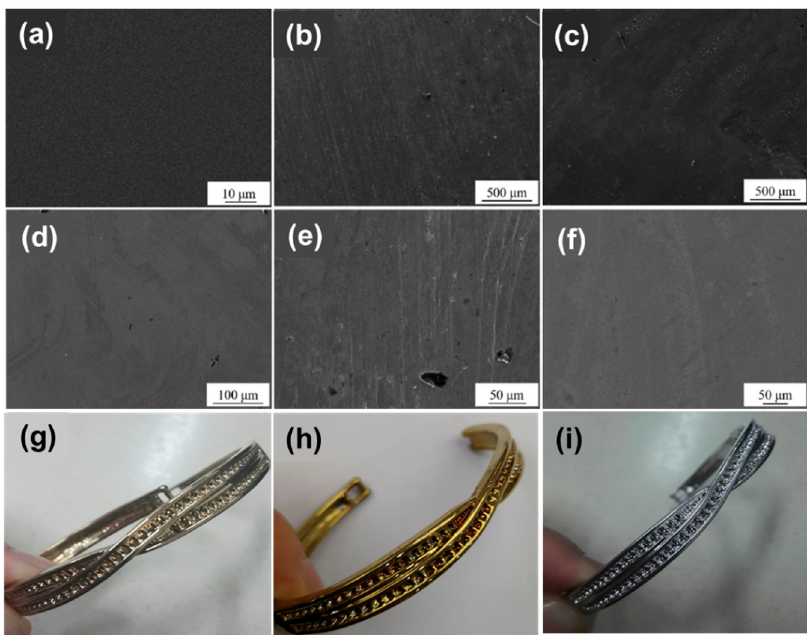
Figure 4. The scanning electron microscope (SEM) images of the as-prepared samples: TiN-1 ( a ), TiN-2 ( b ), TiN-3 ( c ), ZrN-1 ( d ), ZrN-2 ( e ), ZrN-3 ( f ); the picture of ( g ) stainless-steel alloy, ( h ) TiN, ( i ) ZrN.